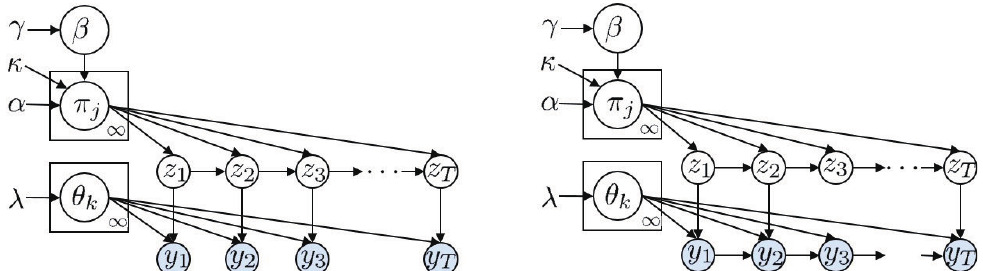
Figure 3. ( Left ) the graphical representation of an HDP-HMM over T time steps. The latent, discrete-valued Markov process z t captures the temporal dependencies in the observations y t . ( Right ) the graphical model for an HDP-VAR( r )-HMM over T time steps. The latent, discrete-valued Markov process z t dictates the linear dynamical model at time t . For an order r switching VAR process ( r = 1 in this paper), the conditionally linear dynamics are completely determined by previous observations y t − 1 . Adapted from [25] by Emily B.